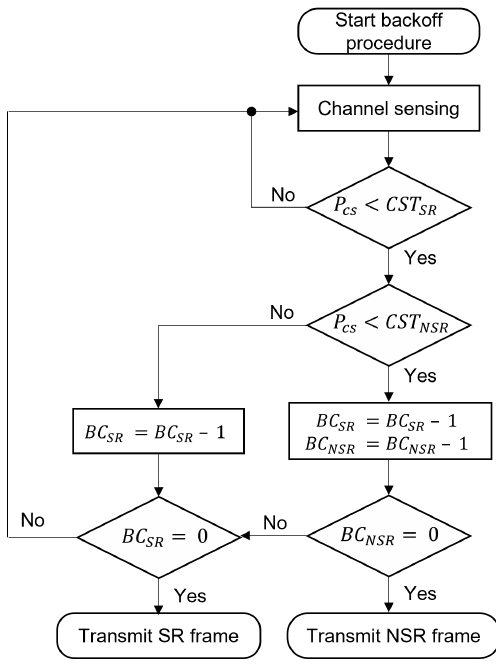
Figure 1. Flowchart of backoff procedure in dual channel access